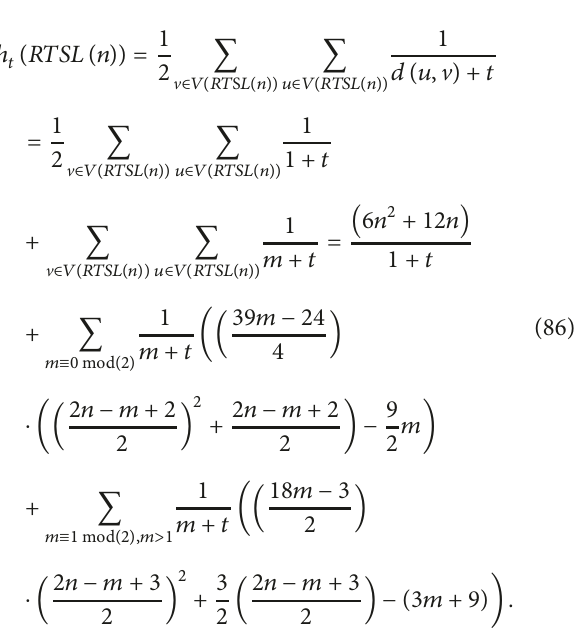
Table 12 contains the values of generalized Harary index of regular triangular silicate network for different values of 𝑛 and